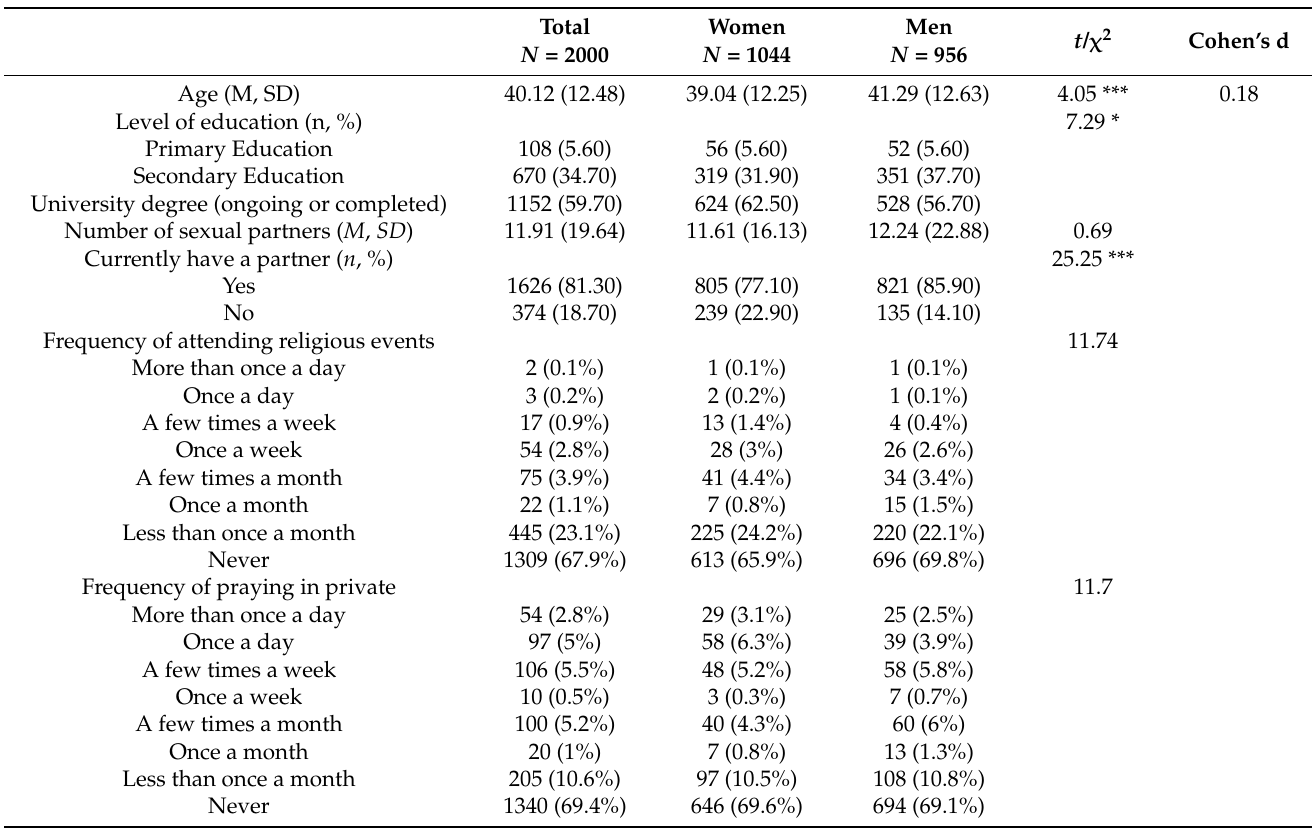
Table 1. Socio-demographic characteristics and differences between women and